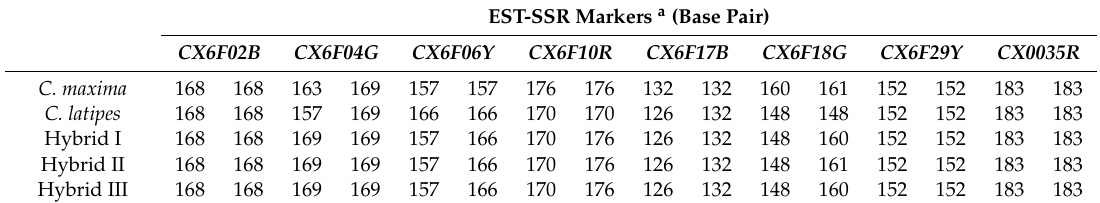
Table 1. Simple Sequence Repeat of C. maxima and C. latipes and their hybrids ( C. maxima × C. latipes ) using eight SSR